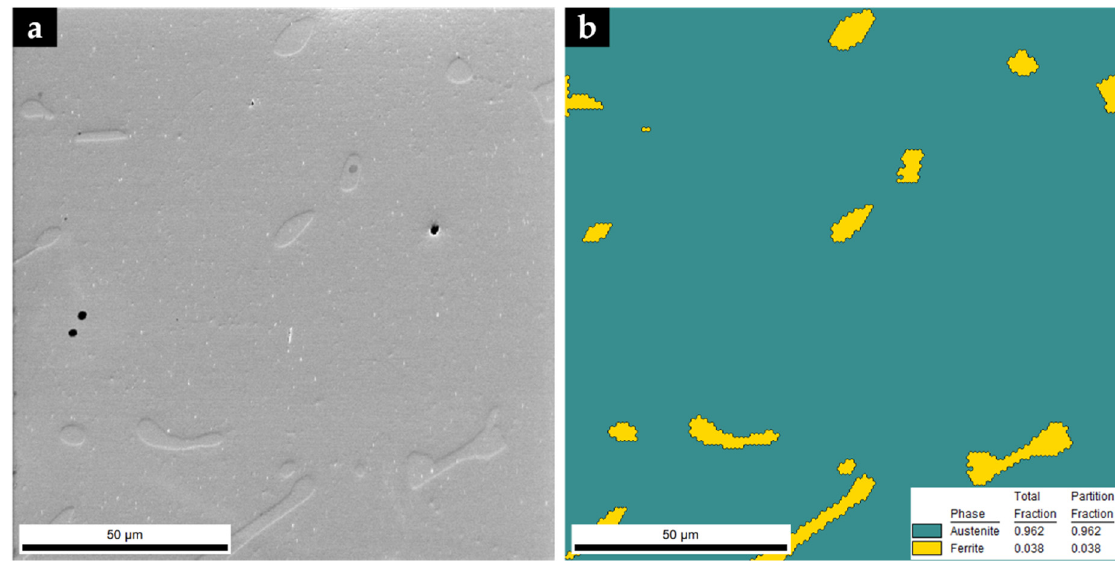
Figure 12. SEM image of the microstructure of the base metal ( a ) and EBSD phase map: γ in dark cyan and α in yellow ( b ). 3.3.2. Metal Matrix Composite Zone The metal matrix composite (MMC) shows three distinct zones, identified by CZ1 (zone nearest surface), CZ2, and CZ3 (inner zone near to the base metal), as can be seen in SEM images of Figure 13.